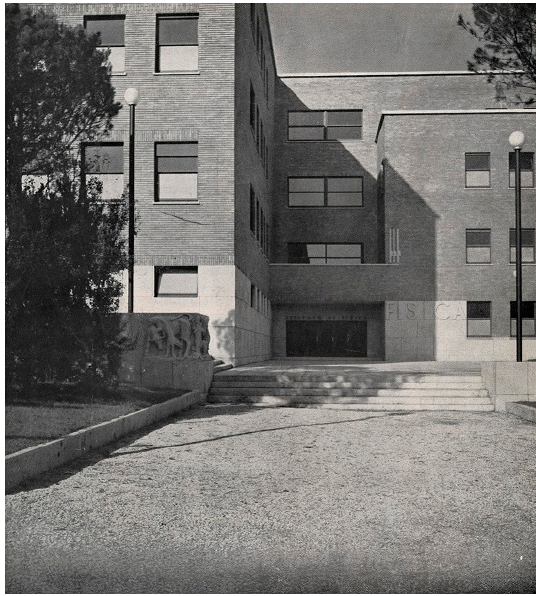
Figure 38. The main entrance. Photo from (De Smaele 1936, p. 9).